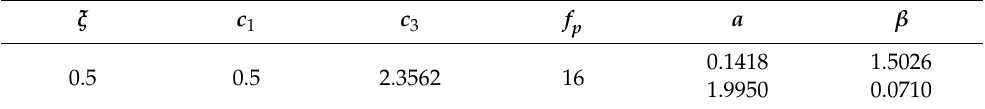
Table 2. Subharmonic resonance dynamic response parameter